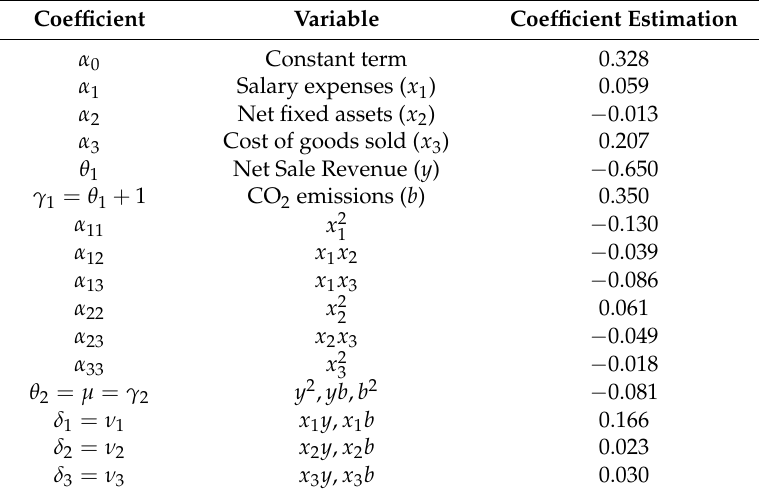
Table 2. Coefficient Estimation of Directional Distance